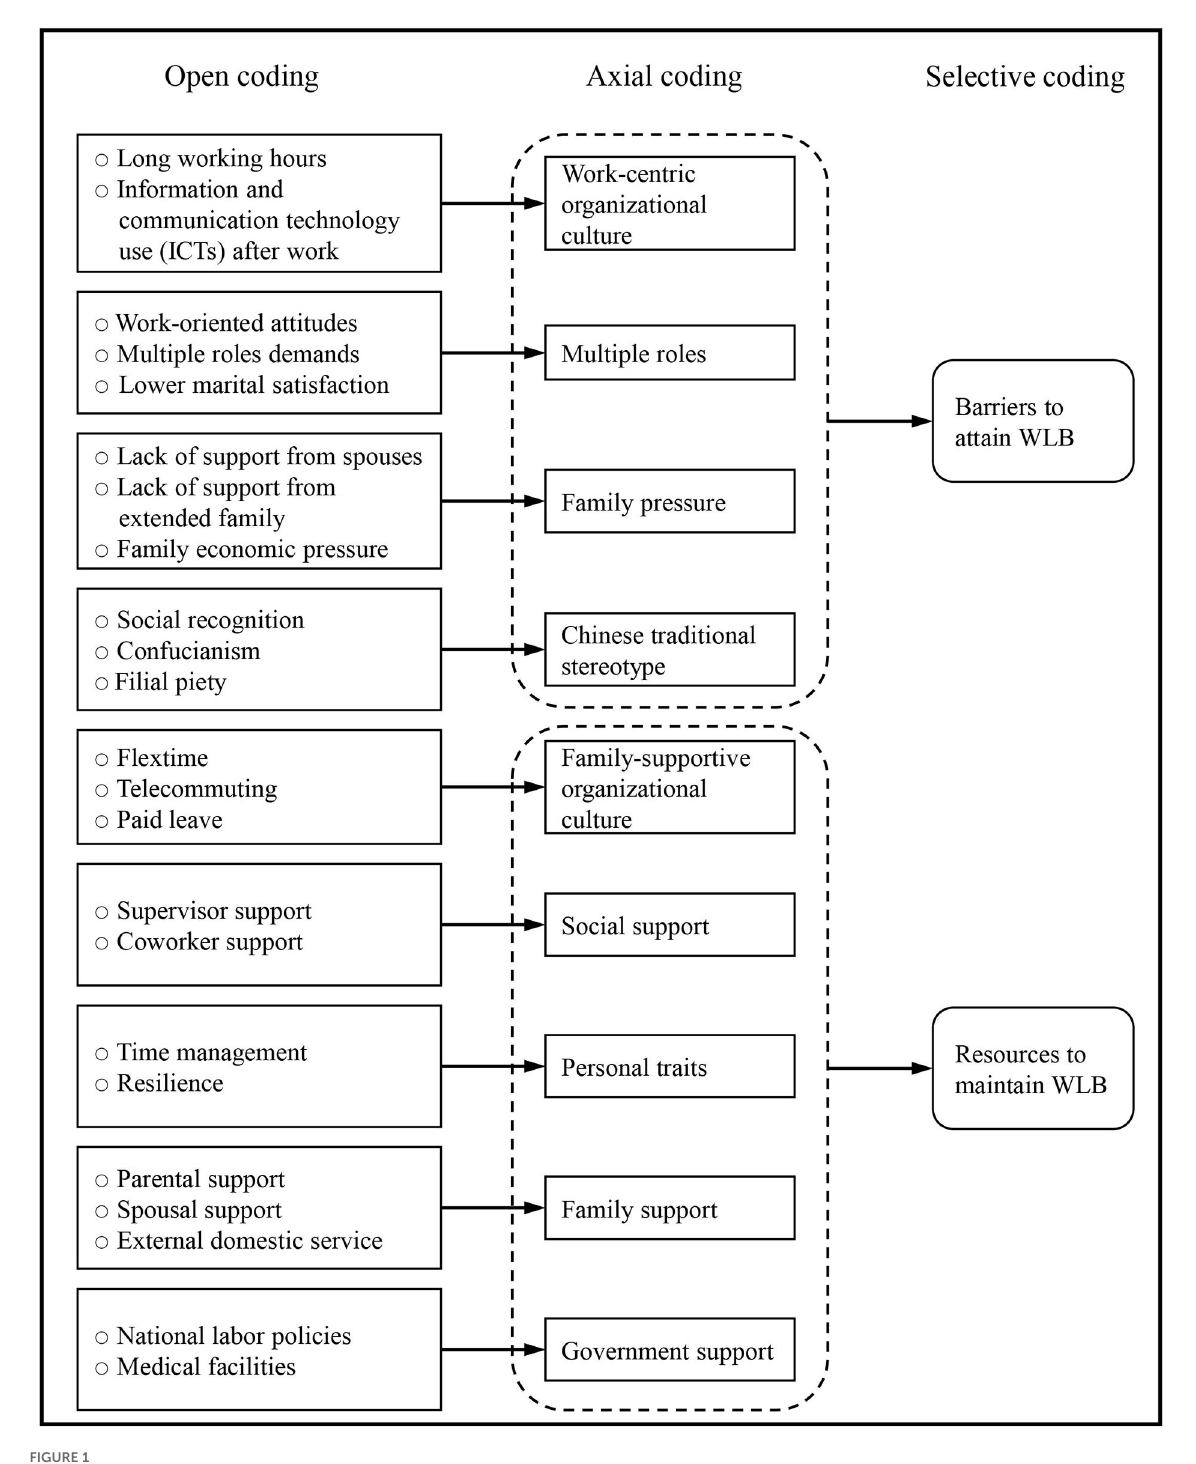
FIGURE1 Data analysis